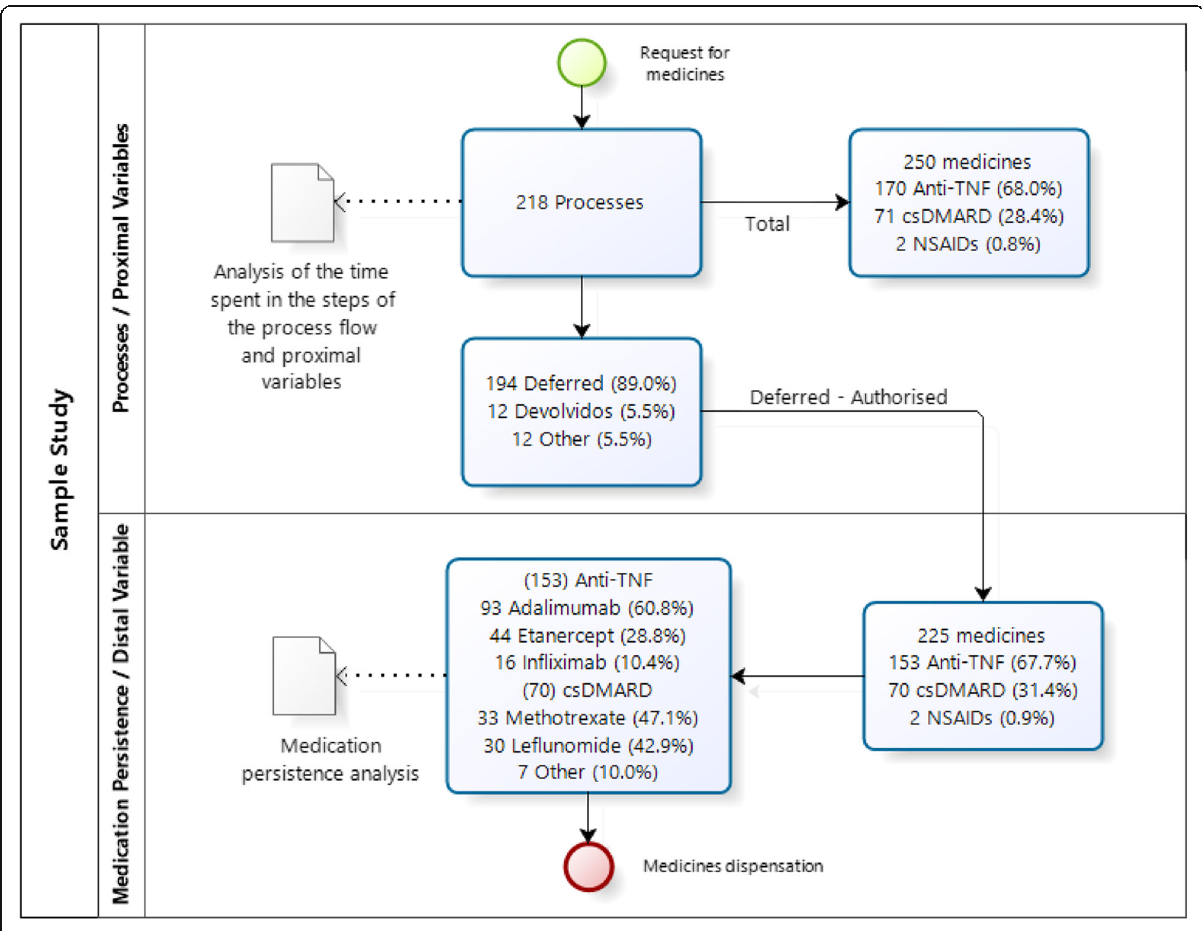
Fig. 2 Quantitative of processes requested and accepted at Belo Horizonte. Legend: csDMARD= conventional synthetic disease-modifying antirheumatic drugs; NSAID = Nonsteroidal anti-inflammatory drug. Proximal variables = cross-sectional variables, collected in the administrative processes. Distal variable = longitudinal variable, collected after 12 months in the information